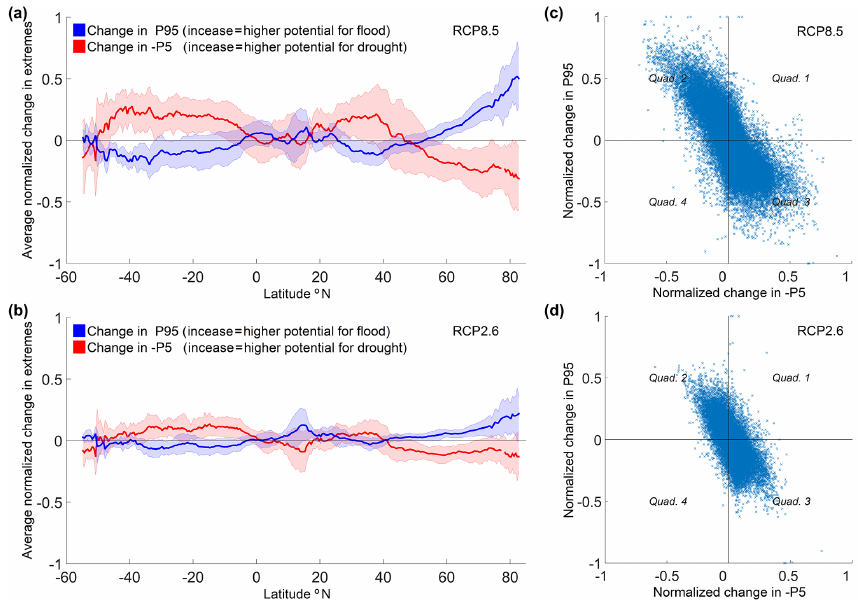
Figure 2. Multi-model change in P95 and P5*–1 under the (a) RCP8.5 and (b) RCP2.6 scenarios, averaged by latitude, and scatter plot of change for each grid cell under the (c) RCP8.5 and (d) RCP2.6 scenarios. The thick lines in the panels (a) and (b) show the ensemble mean value of all 25 GCM-GHM combination datasets, and the shading denotes ± 1